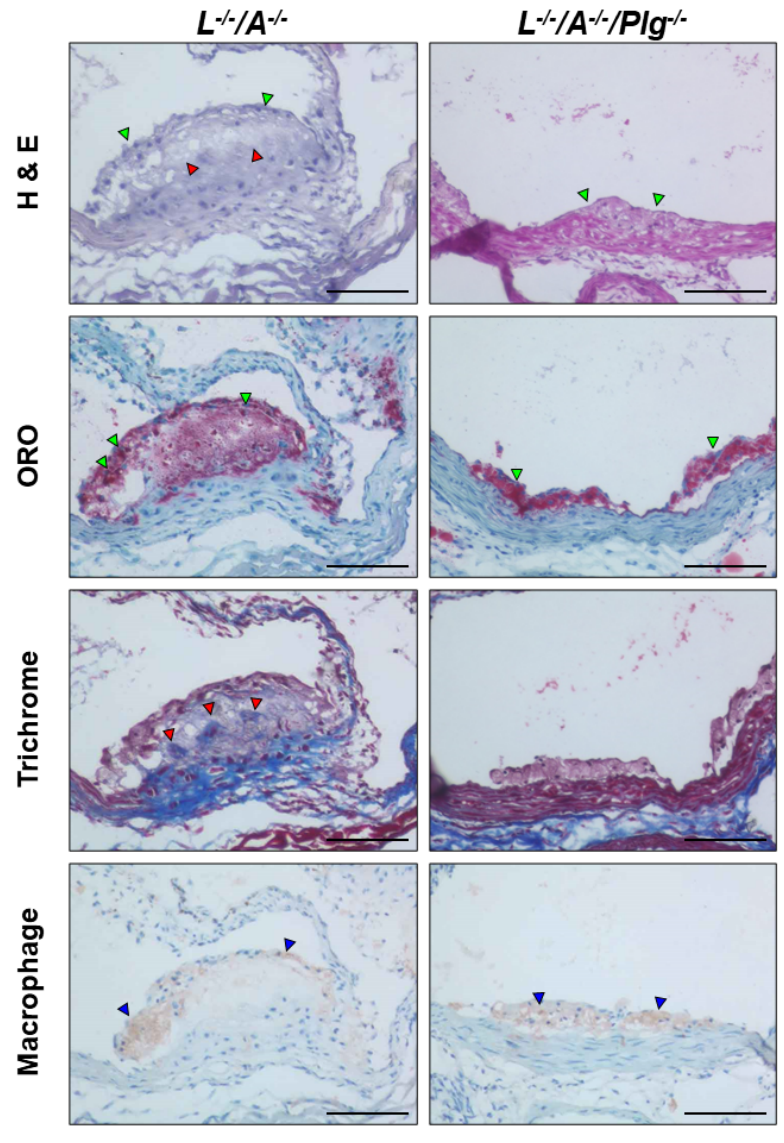
Figure 3. Stained plaque from L − / − /A − / − and L − / − /A − / − /Plg − / − male mice at 18 wk of age. H&E stains in L − / − /A − / − demonstrated cellular cap formation on the surface of the plaque (green arrowheads) with acellular areas (red arrowheads). H&E stains in L − / − /A − / − /Plg − / − mice indicated that the size of plaque was very small and only a few cell layers were observed (green arrowheads). ORO stains in L − / − /A − / − mice demonstrated that the dense fat accumulation was mainly localized on the surface of the plaque (green arrowheads). Fat accumulation was diffuse in the core. ORO stains in L − / − /A − / − /Plg − / − mice demonstrated small but very dense fat accumulation in the plaque (green arrowheads), which was found earlier in L − / − /A − / − mice. Masson’s trichrome stains in L − / − /A − / − mice showed diffuse and patchy collagen deposition (red arrowheads). Masson’s trichrome stains in L − / − /A − / − /Plg − / − mice indicated an absence of collagen deposition in the plaque. Macrophage immunostains in L − / − /A − / − mice showed positive stains mainly localized in the cap area (blue arrowheads). Macrophage immunostains in L − / − /A − / − /Plg − / − mice indicated that almost all of the cells were positive in the small cap (blue arrowheads). Original magnification, 200×. Bar = 100 µm.